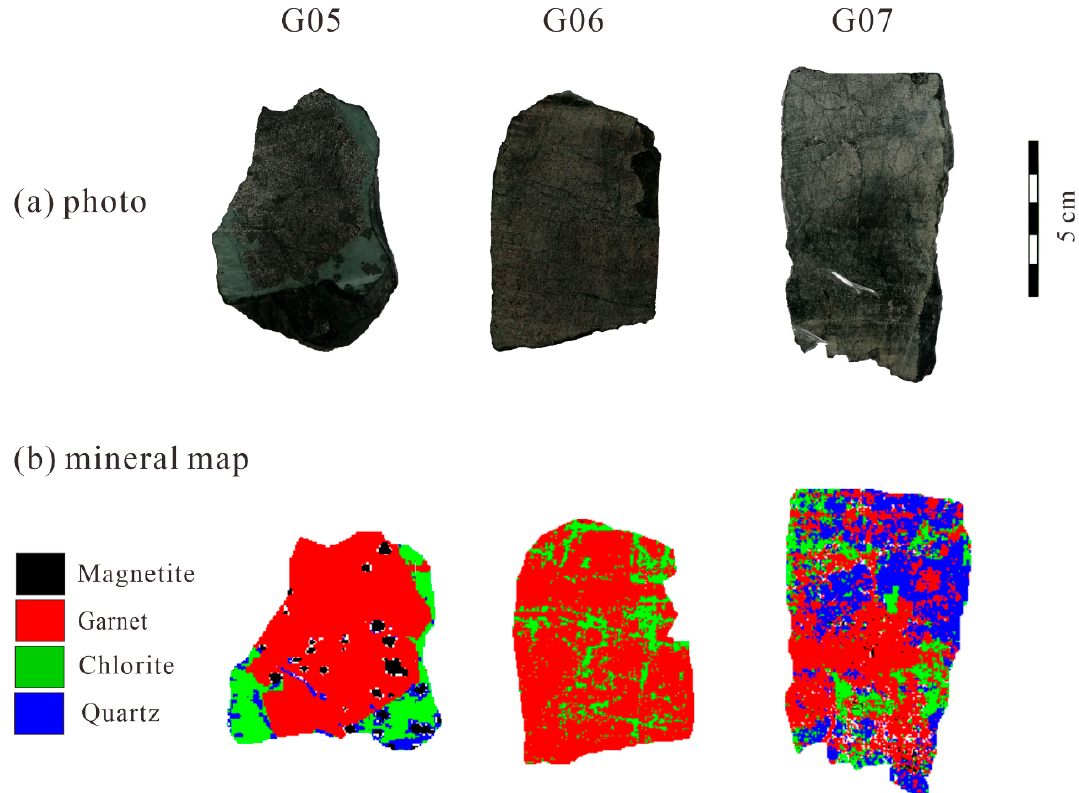
Figure 7. Identified minerals derived from the HySpex image.